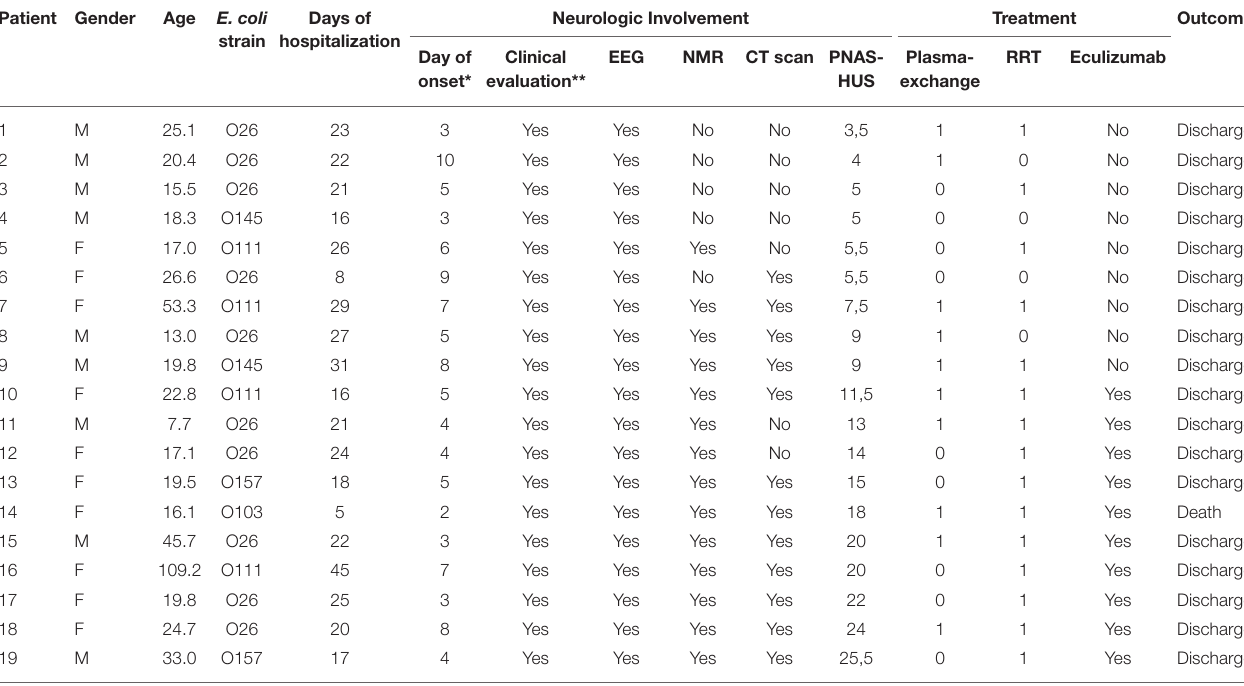
TABLE 1 | Main clinical, laboratory, and therapeutic information on STEC-HUS patients with neurologic involvement. Patient Gender Age E. coli